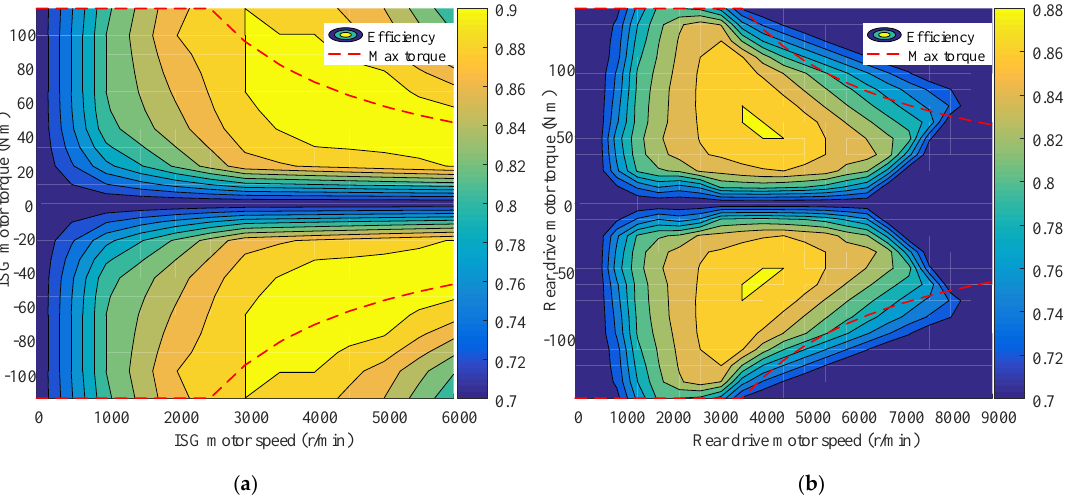
Figure 2. ( a ) The base integrated starter and generator (ISG) motor e ffi ciency map and ( b ) the base rear-drive motor e ffi ciency map.